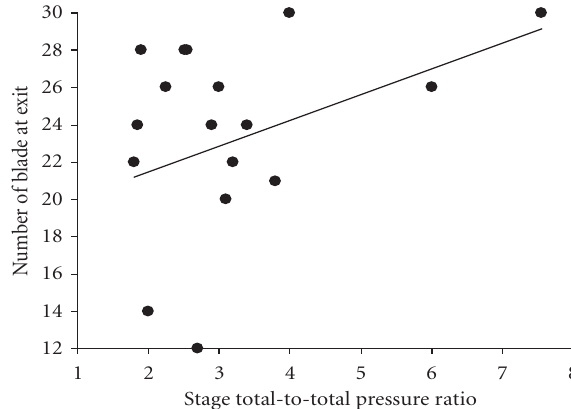
Figure 7: The number of blades at the exit versus stage pressure ratio for split impellers.